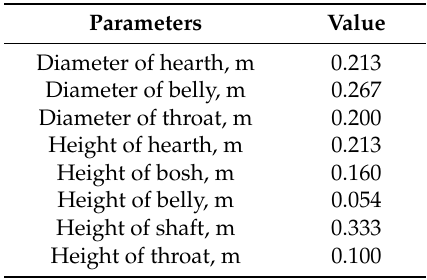
Table 1. Dimensions of the experimental